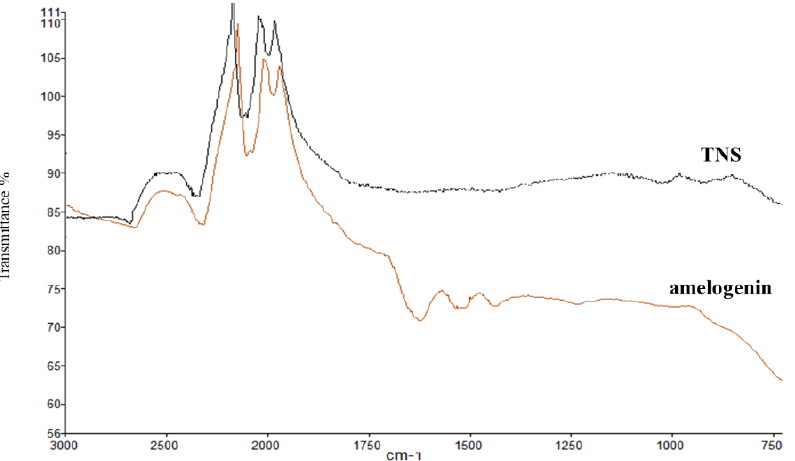
Figure 4. FTIR analysis of test and control groups.